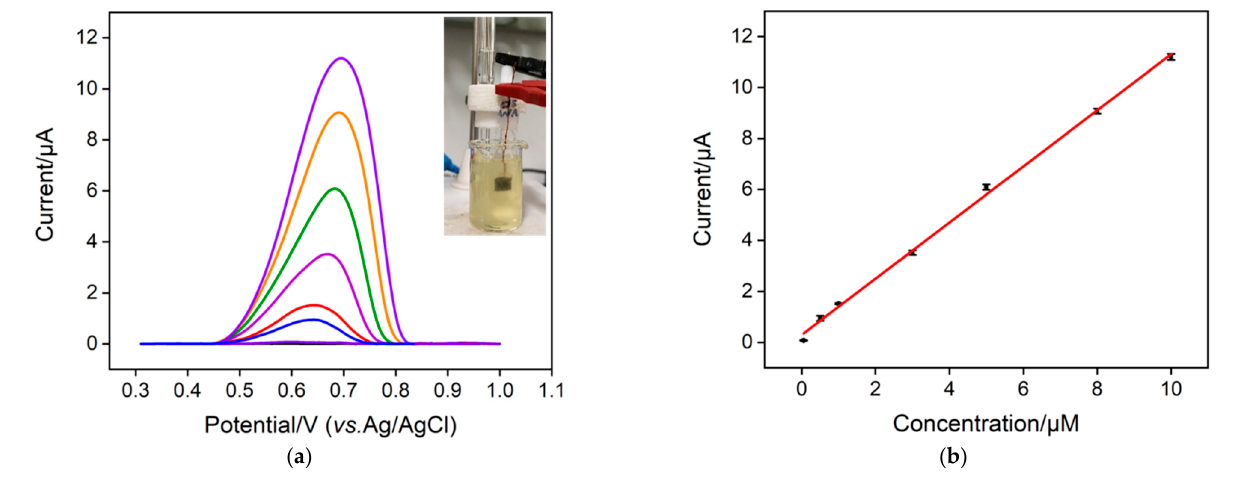
Figure 7. ( a ) DPV responses of VMSF/p-3DG electrode to various concentrations of TR in urine (diluted by a factor of 50). ( b ) The corresponding calibration curves. Error bars denote the relative standard deviation (RSD) of three measurements.